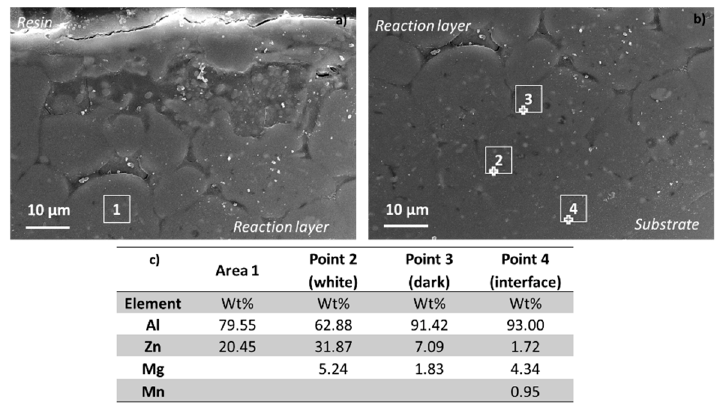
Figure 7. FESEM-EDS analyses of Al5182 Zn-sput-Zn. ( a ) Micrograph of the reaction layer; ( b ) magnification of the reaction layer / interface; and ( c ) semiquantitative EDS analyses of selected areas evidenced in panel ( b ).